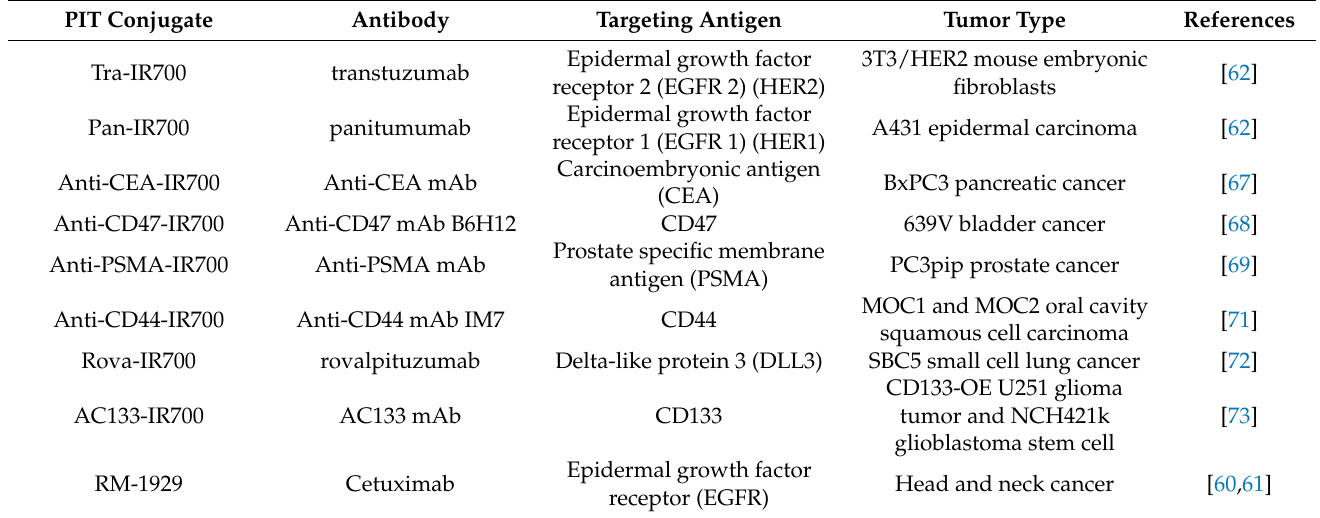
Table 2. Summary of IR700-based photoimmunotherapy.